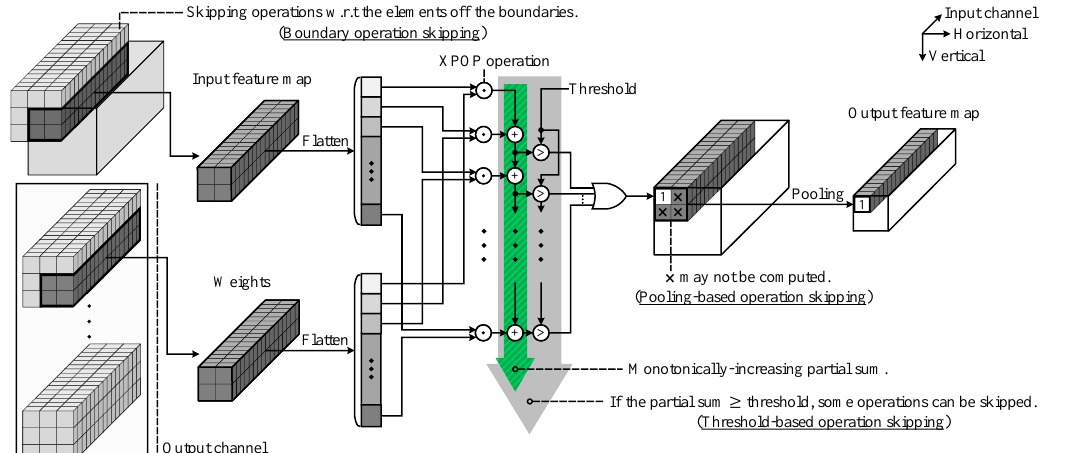
Figure 1. Conventional procedure for computing each block composing the BCNN inference process, where the input and output feature maps and weights are multi-dimensional tensors in which each element is represented by a single